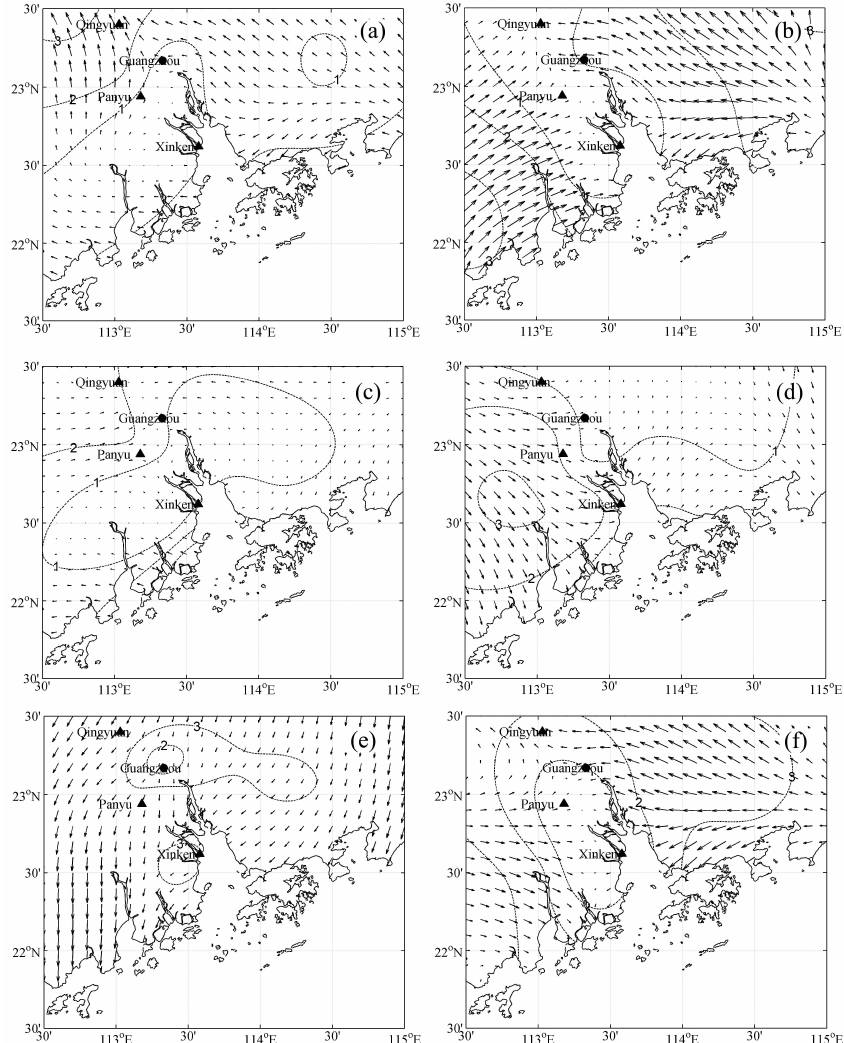
Fig. 3. Wind fields from the main meteorological stations at the PRD region. (a, b) 02:00LST on 14 and 16 October 2004, (c, d) 02:00LST on 23 and 25 July 2006, and (e, f) 02:00LST on 26 and 28 October